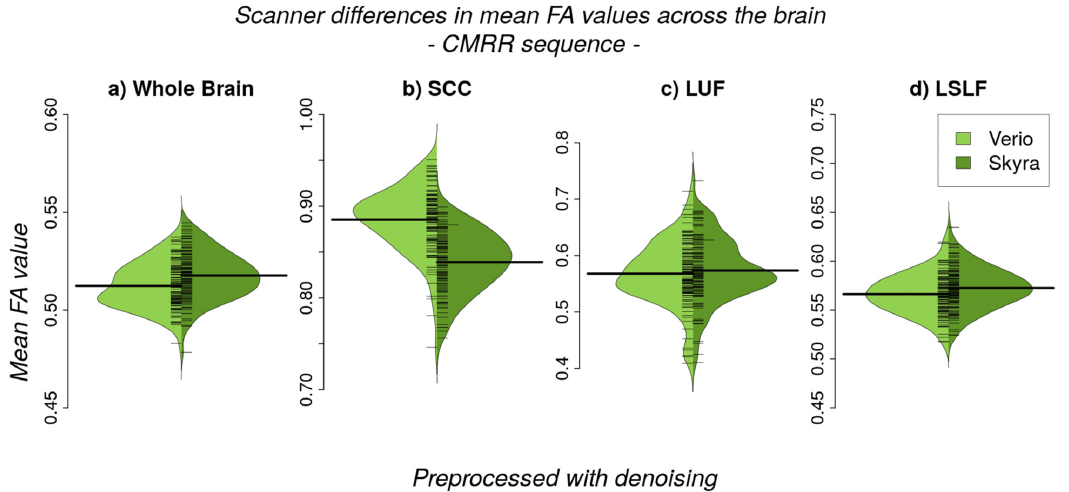
Figure 3. Scanner differences in the mean FA value of the white matter (WM) skeleton (CMRR sequence, after denoising) for ( a ) whole brain and region-of-interest analyses ( b – d )). ( a ) On the whole brain level, Skyra delivers higher FA values than Verio (~1%, BF >> 3). ( b ) The splenium of the corpus callosum (SCC), ( c ) left uncinate fascicle (LUF) and ( d ) the left superior longitudinal fascicle (LSLF) highlight the differences in direction and magnitude of the scanner differences across ROIs: differences between scanners in percentages (cid:3040)(cid:3032)(cid:3028)(cid:3041) (cid:3007)(cid:3002) (cid:3049)(cid:3028)(cid:3039)(cid:3048)(cid:3032) (cid:4666)(cid:3020)(cid:3038)(cid:3052)(cid:3045)(cid:3028)(cid:4667)(cid:2879)(cid:3040)(cid:3032)(cid:3028)(cid:3041) (cid:3007)(cid:3002) (cid:3049)(cid:3028)(cid:3039)(cid:3048)(cid:3032) (cid:4666)(cid:3023)(cid:3032)(cid:3045)(cid:3036)(cid:3042)(cid:4667) (cid:3040)(cid:3032)(cid:3028)(cid:3041) (cid:3007)(cid:3002) (cid:3049)(cid:3028)(cid:3039)(cid:3048)(cid:3032) (cid:4666)(cid:3023)(cid:3032)(cid:3045)(cid:3036)(cid:3042)(cid:4667) × 100 : SCC: ~ − 5.2% (BF >> 3), LUF: ~1% (BF = 1.1), LSLF: ~1.1% (BF >> 3).